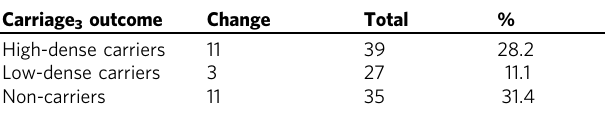
Table 2 Microbiota cluster changes Carriage 3